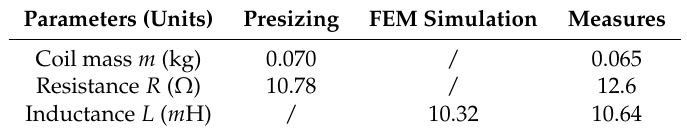
Table 2. Recapitulative table of parameters: presizing, FEM simulation and measurements. Parameters (Units)